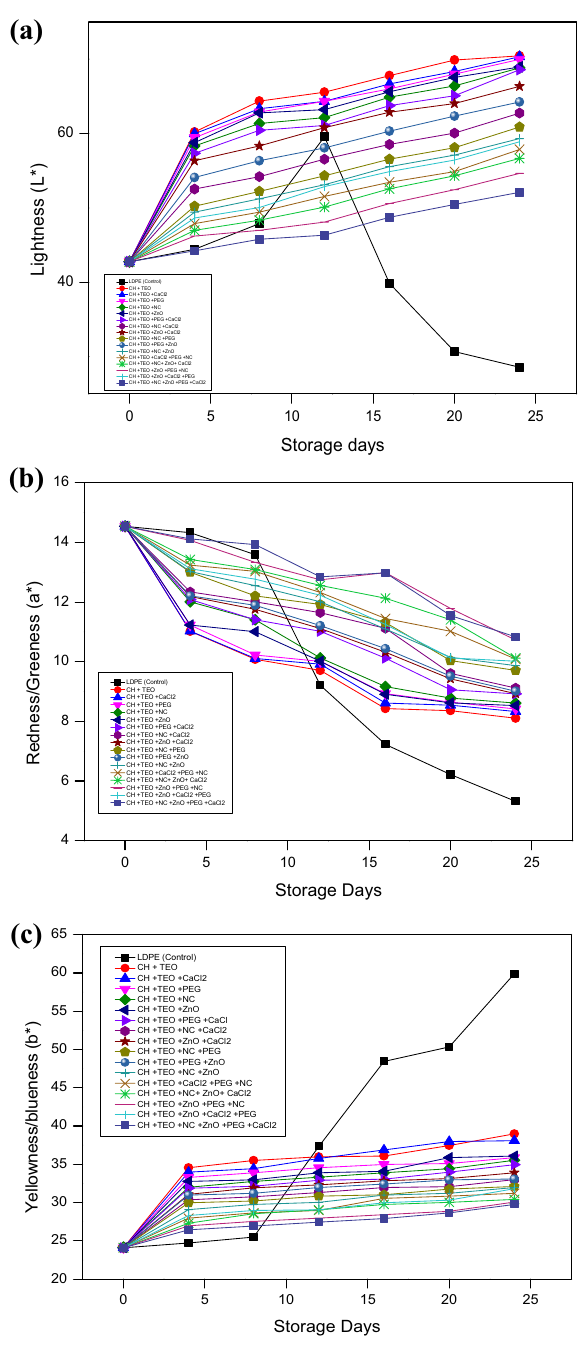
Figure 4. ( a ) Effect of different chitosan-based films and storage days on lightness value ( L* ) of collard greens. ( b) Effect of different chitosan-based films and storage days on color ( a* value) of collard greens. ( c) Effect of different chitosan-based films and storage days on color ( b* value) of collard